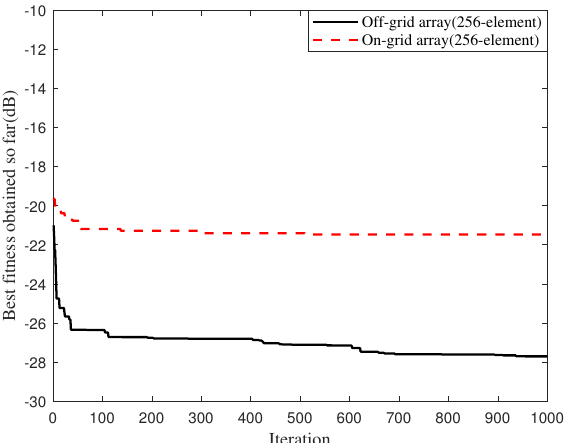
Figure 16. The iterative process of the on-grid large-scale low-frequency senor array (256-element) based on the proposed method.